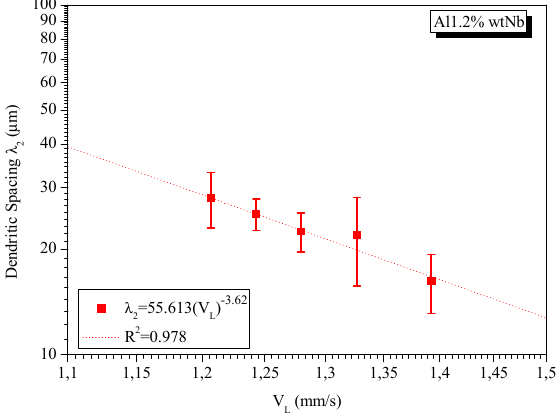
Figure 13. Experimental equation of the secondary dendritic spacing as a function of liquidus isotherm velocity for Al–1.2 Nb (wt.%).